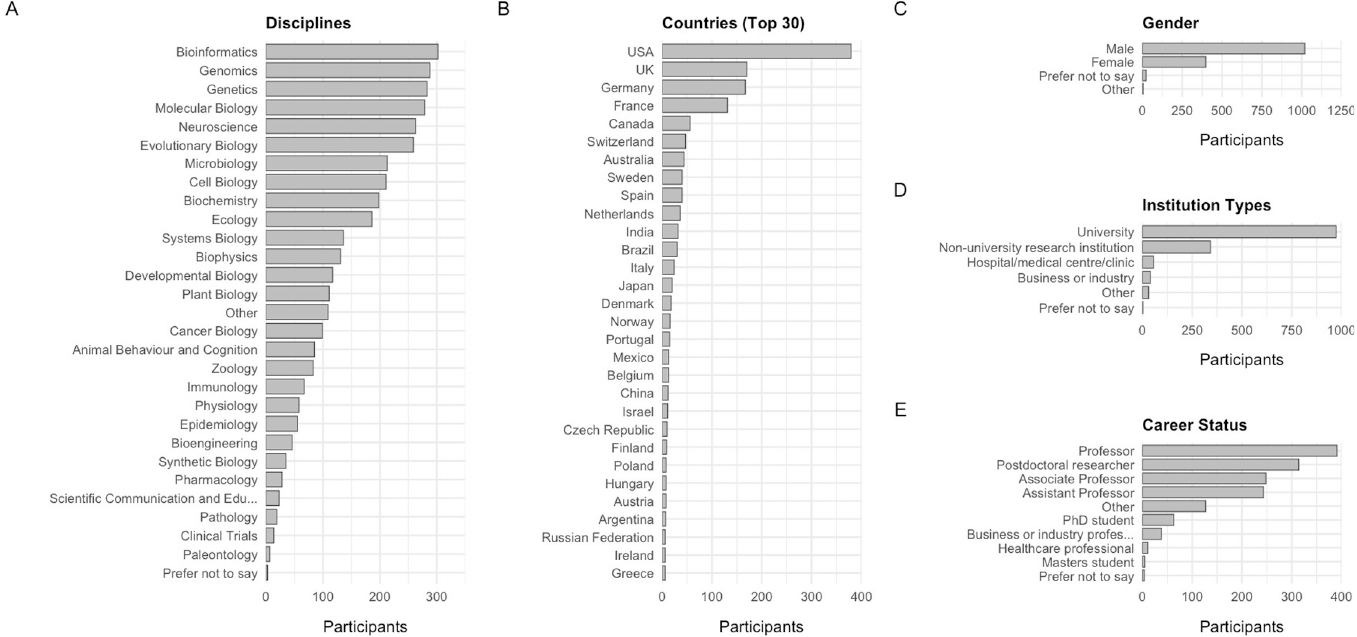
Fig 2. Demographics of survey participants (N = 1,444). (A) Main scientific disciplines. Note that disciplines correspond to bioRxiv submission categories, and participants could select multiple disciplines. (B) Country of residence. The top 30 countries by total participants are shown. (C) Gender. (D) Institution type. (E) Career